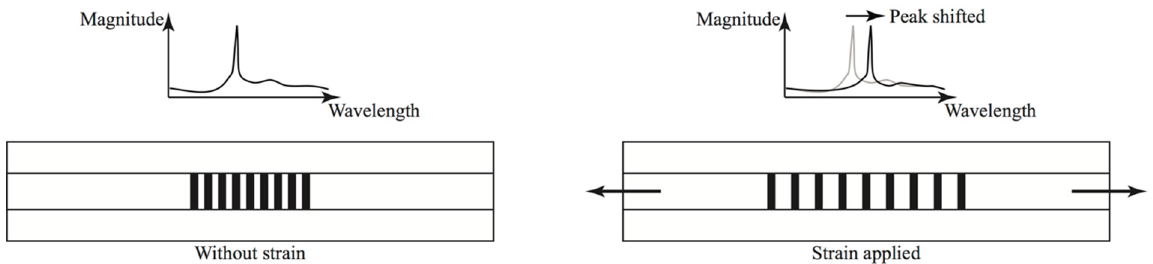
Figure 2. Bragg wavelength shift of reflected light when strain is applied on FBG sensor.